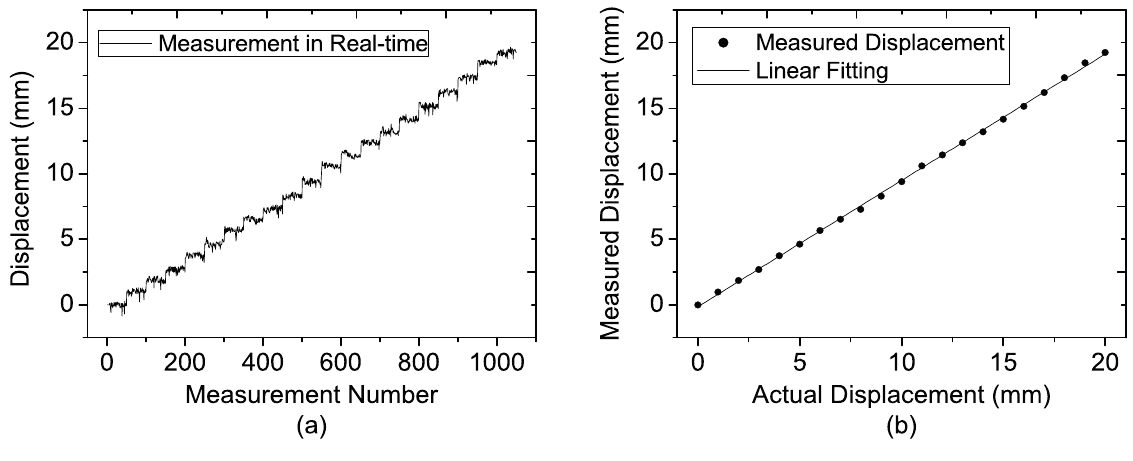
Figure 14. Measured results of the target located at the distance of 40 m at each step for ( a ) 50 single-measurement results; ( b ) Average of the 50 single-measurement